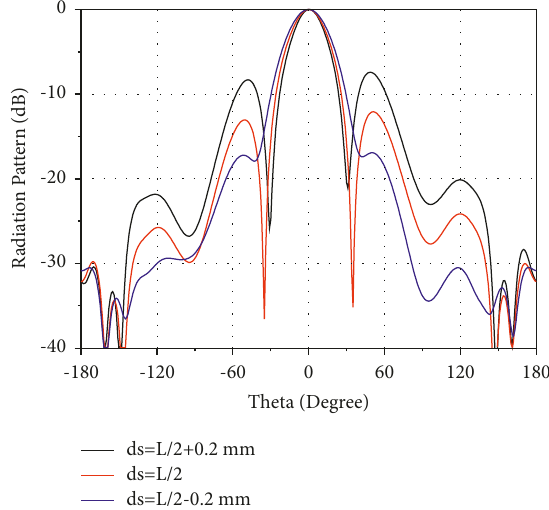
Figure 4: The relationship between the distance of sub-elements d and the pattern in E-plane at